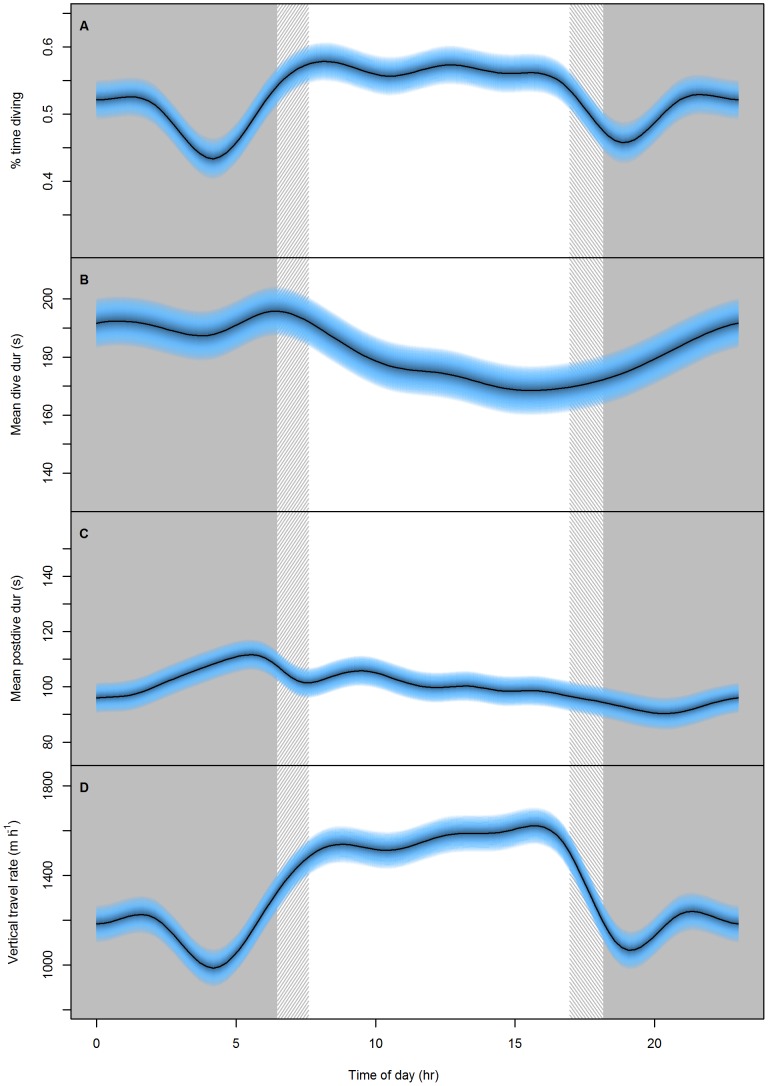
Foraging effort response to time of day.The predicted response of A) proportion of time diving (%), B) mean dive duration (s), C) mean post-dive duration (s) and D) vertical distance covered (m·h−1) in female Australian fur seals to different times of the day. Grey areas represent local night time and the hatched regions represent the band of time that sunrise/sunset occurred over the study period. Blue bands represent the 95% confidence intervals around the predicted response. (see Table 1 for statistical results).